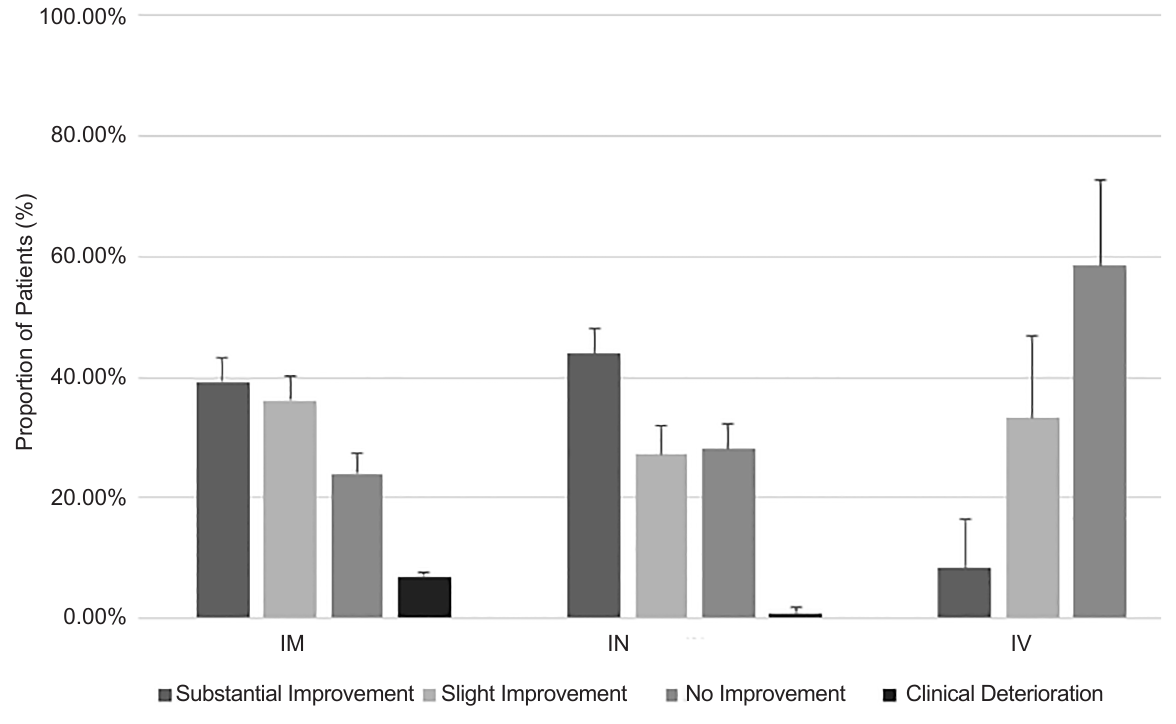
Figure 2. Subjective clinical change after initial midazolam administration for behavioral emergencies as reported by paramedics.